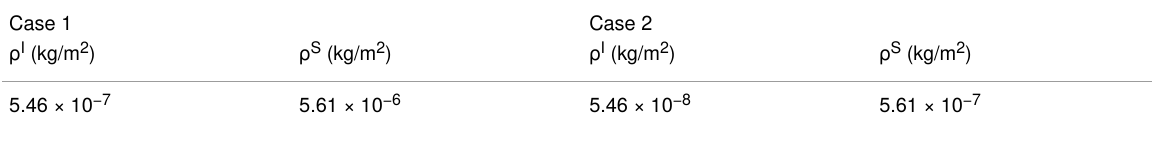
Table 5: Two cases of surface density studied.